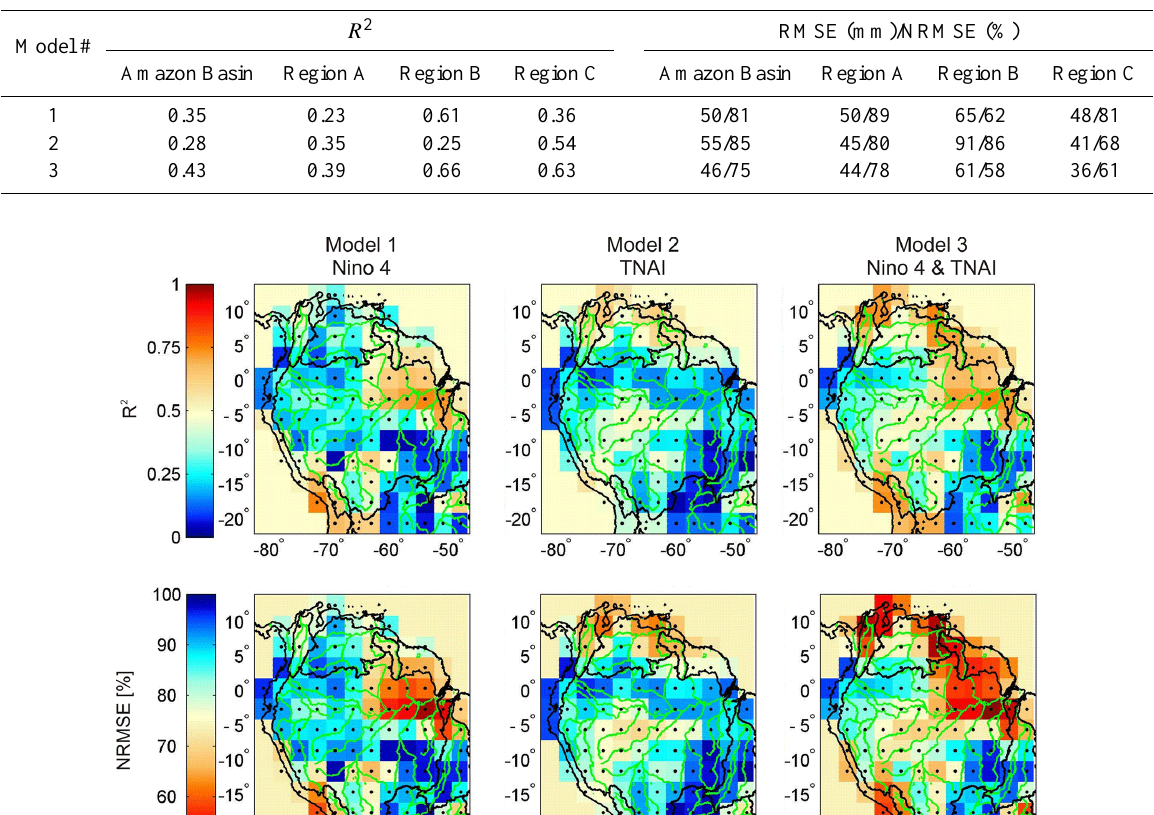
Table 2. Statistics of model performance averaged within each region delineated in Fig. 1. Skill metrics included the coefficient of determi- nation ( R 2 ), root mean square error (RMSE), and root mean square error normalized by the standard deviation of the observations (NRMSE). Every model fit is significant ( F test, p < 0 . 05) within at least 90% of the cells in each region.